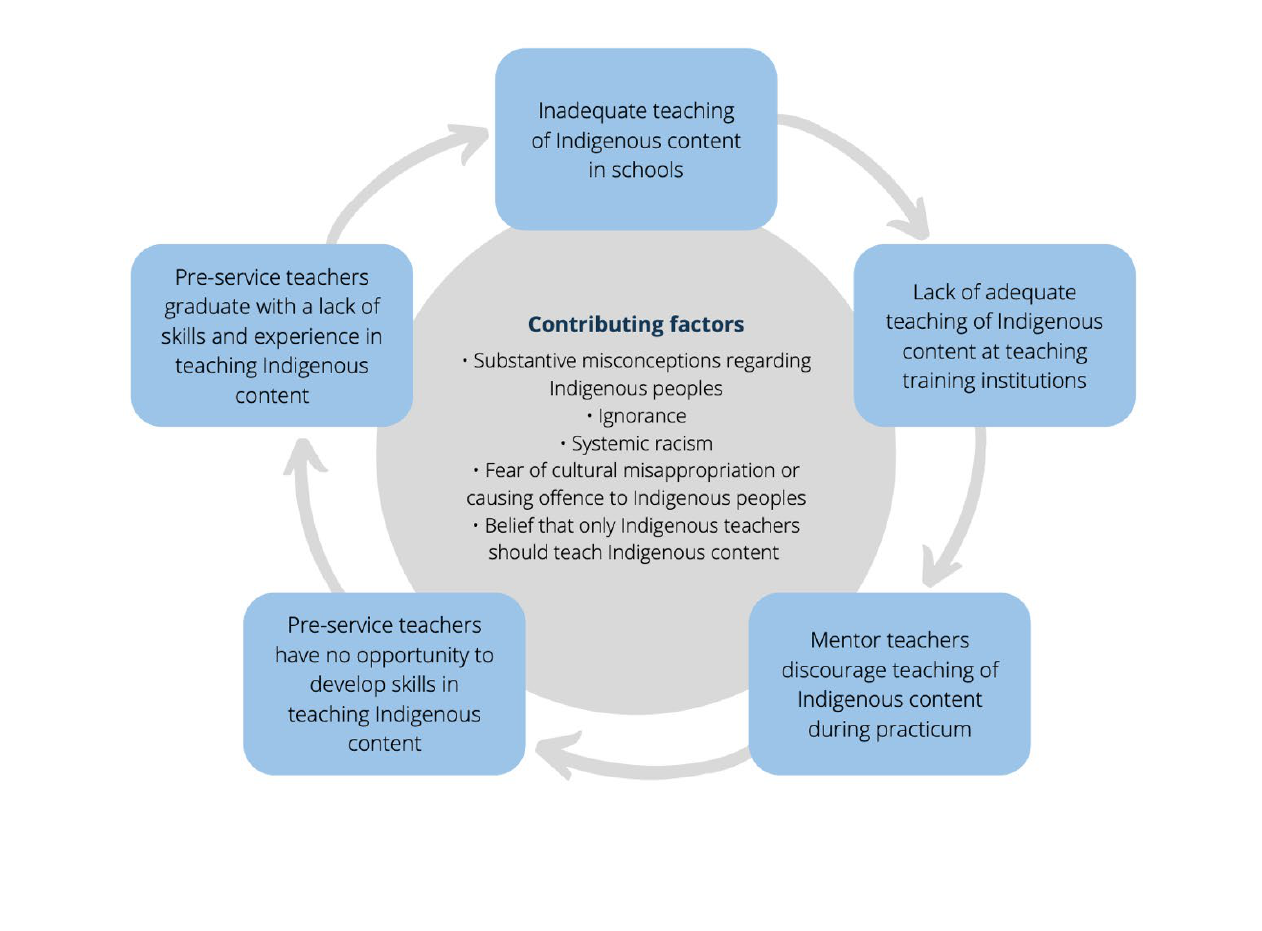
Figure 1. Cycle of insufficient teaching and learning of Indigenous content in